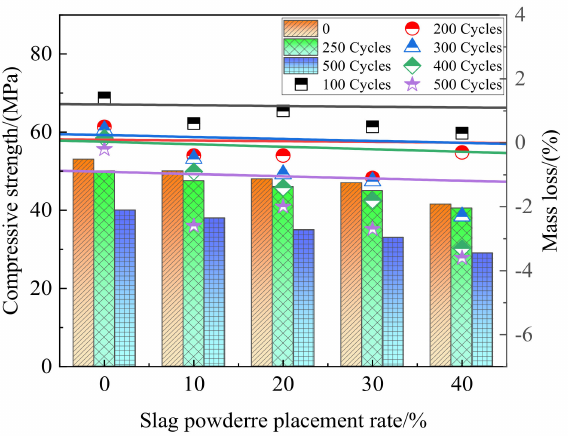
Figure 20. Influence of different amounts of slag powder and different freeze-thaw cycles on com- pressive strength and quality loss of coal gangue concrete [102].